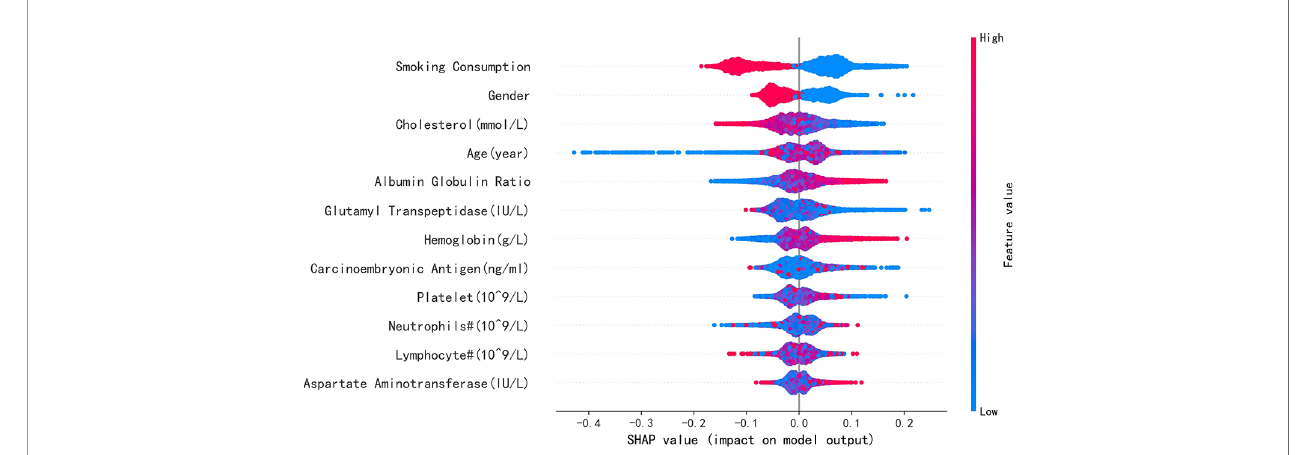
FIGURE 3 | SHAP summary plot of the 12 features of the RF model. The higher the SHAP value of single feature, the higher the possibility of EGFR mutation. Red represents closer with this mutation, and blue represents apposite possibility.